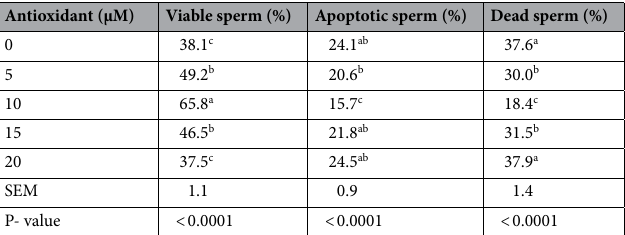
Table 2. Effect of different levels of tempol on viability and apoptotic-like changes of rooster sperm after freeze-thawing. Different letters within the same columns show significant differences among the groups (P < 0.05).